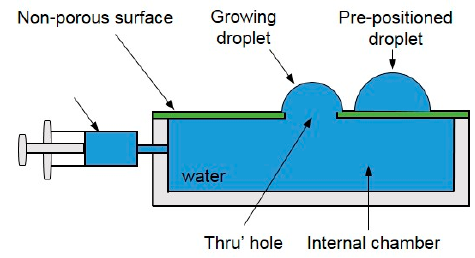
Figure 11. Schematic of the droplet coalescence apparatus using syringe injection.